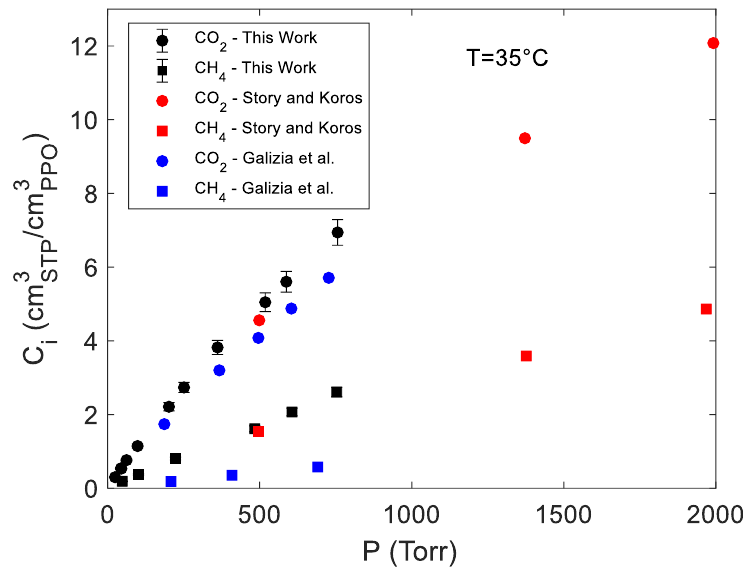
Figure 3. Sorption isotherms of pure CO 2 and CH 4 in amorphous PPO from the present investigation compared with the literature data [7,31].